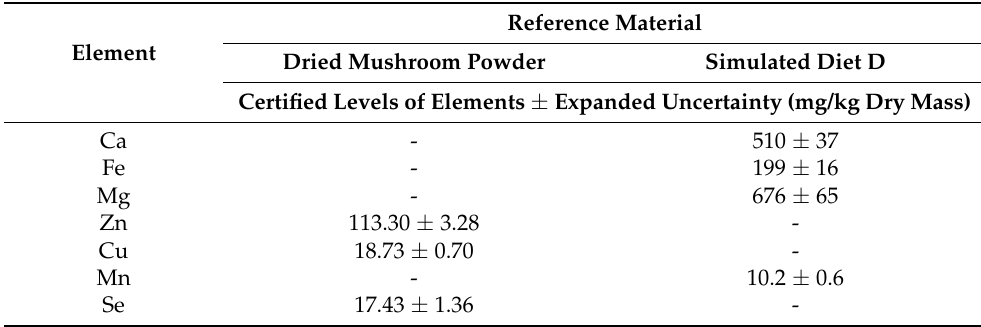
Table 3. Certified reference materials used in checking accuracy of methods used for determining the content of elements in dried